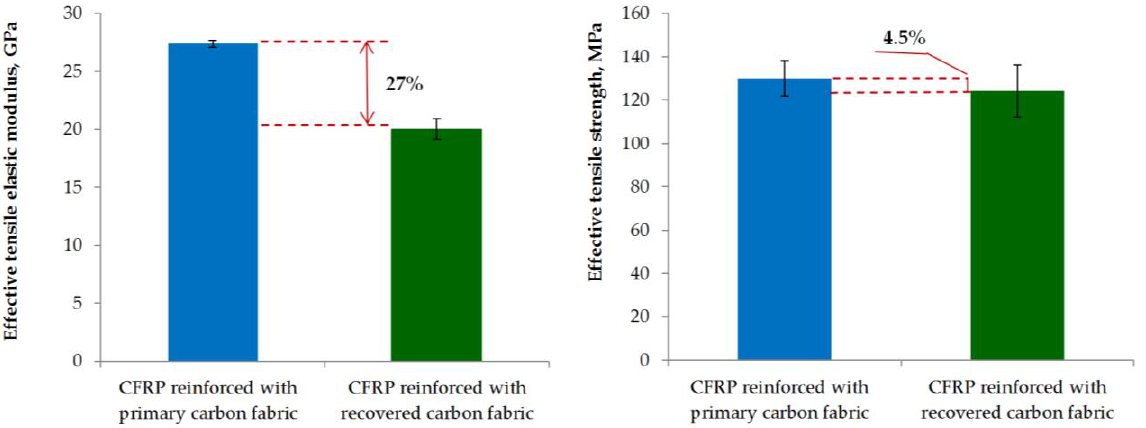
Figure 8. Mechanical characteristics of CFRP with primary and recycled carbon fiber textile.